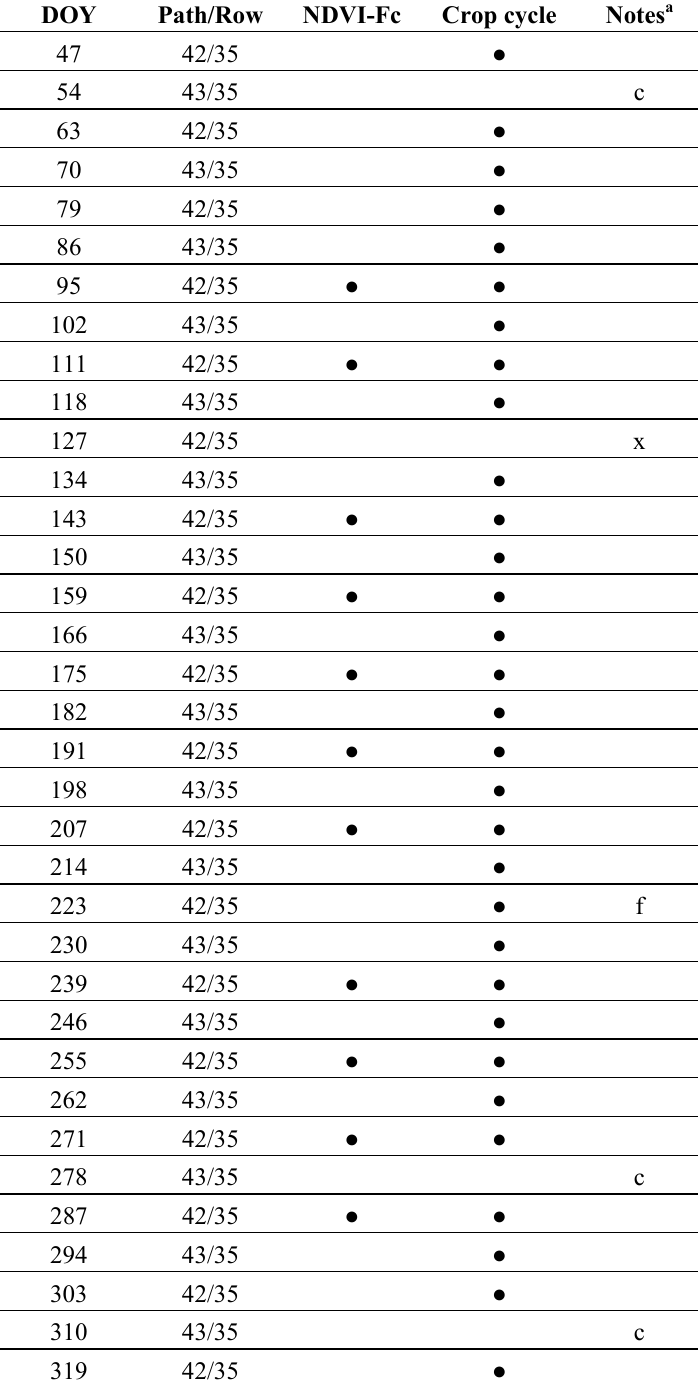
Table 1. Landsat-5 TM scenes used for Objective 1: Development of NDVI-Fc relationship (column 3), and Objective 2: Crop-cycle monitoring (column